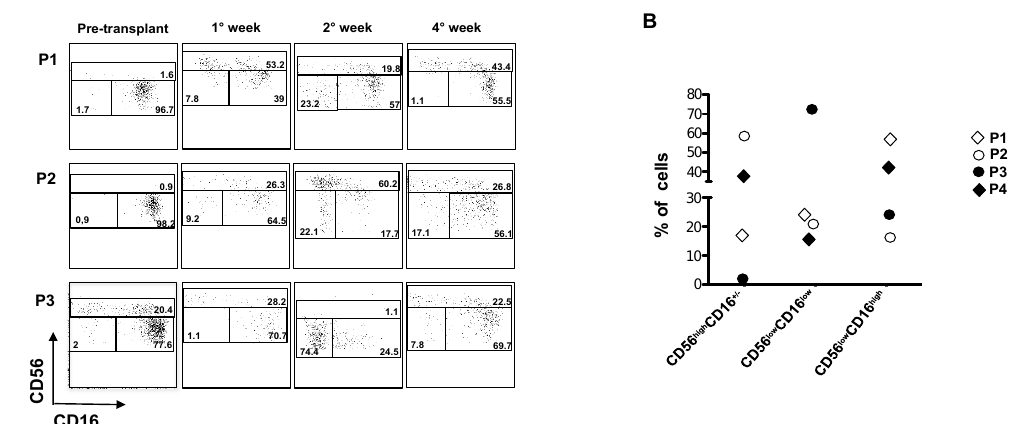
Figure 4. NK cell subset distribution after autologous HSCT. Analysis of NK cell subsets derived from PB of MM patients after transplant. Representative dot plots of NK cell subset distribution on CD45 + CD56 + CD3 - cells derived from three patients (P1, P2 and P3) at different time after transplant were shown ( A ). Percentage of CD56 high CD16 +/ − , CD56 low CD16 low and CD56 low CD16 high of four different MM patients (P1, P2, P3 and P4) after two weeks from transplantation. Each symbol represents a patient ( B ).